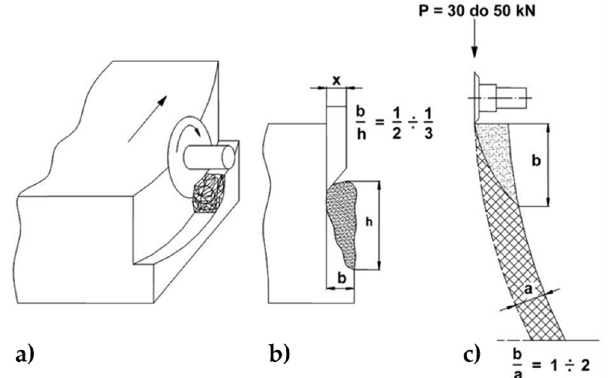
Figure 4. Diagram of the back incision mining method principle: ( a ) general scheme, ( b ) parameters of the output piece chipped from the solid rock, ( c ) parameters of the mining process [17]. However, in this method, there occur strongly changeable side forces on disk tools edges.